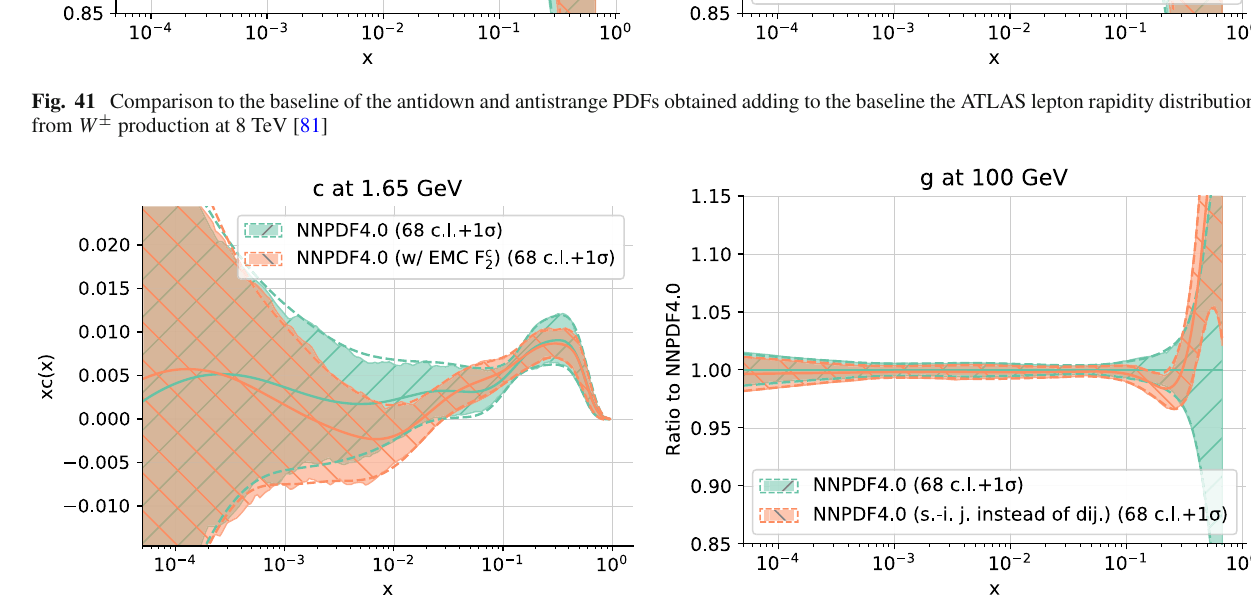
compared and normalized the baseline from a determination replacing 7 TeV ATLAS and CMS dijet data with single-inclusive